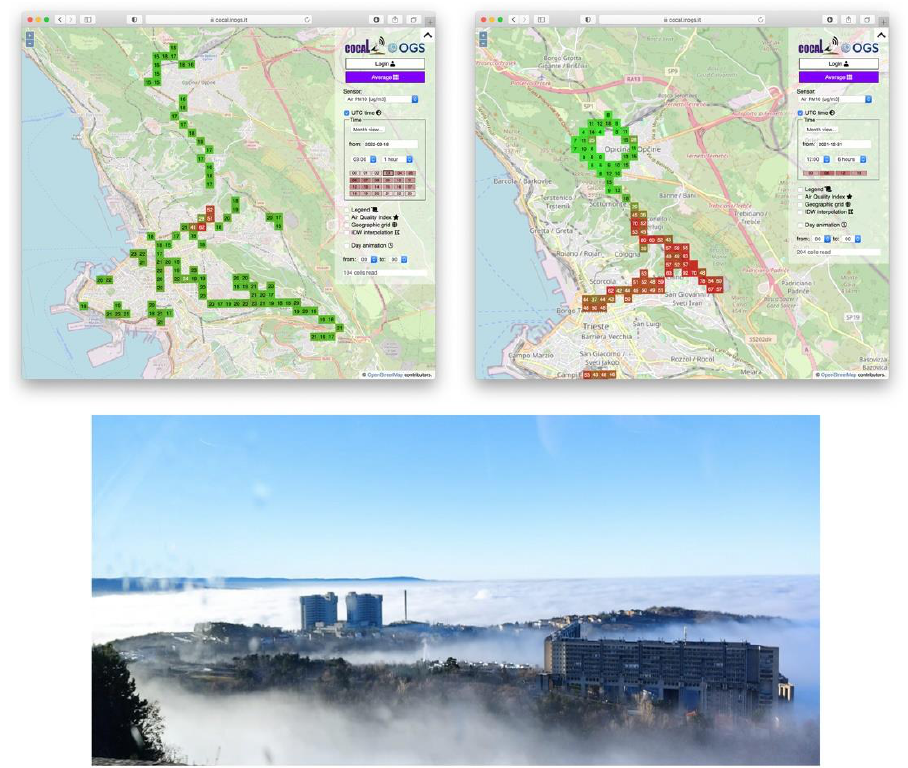
Figure 7. Examples of the application of near-real time web-based monitoring: road constructions (upper left); temperature inversion (upper right); photo of the atmospheric phenomenon from uphill (lower).